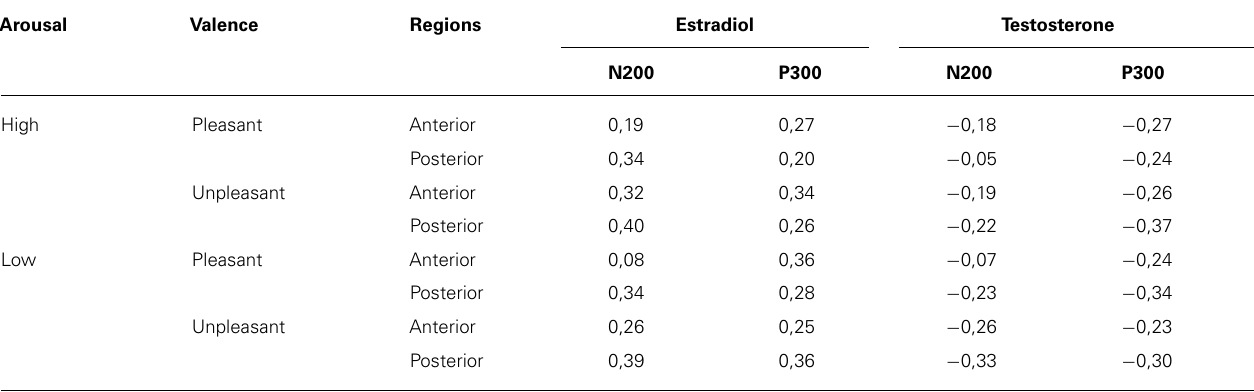
Table 6 | Correlations between gonadal hormones and N200/P300 amplitude in response to arousal and valence conditions across regions (Schizophrenia group). Arousal Valence Regions